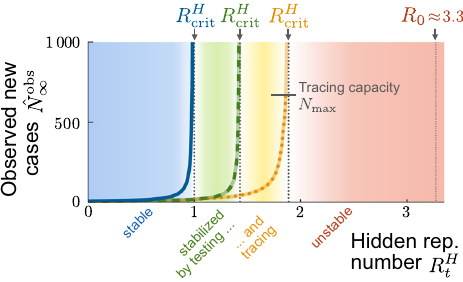
Fig. 5 Testing and tracing give rise to two TTI-stabilized regimes of spreading dynamics. In addition to the intrinsically stable regime of the simple SIR model (blue region), our model exhibits two TTI-stabilized regimes that arise from the isolation of formerly “ hidden ” infected individuals uncovered through symptom-based testing alone (green region) or additional contact tracing (amber region). Due to the external in fl ux, the number of observed new cases reaches a nonzero equilibrium ^ N obs 1 that depends on the hidden reproductive number (colored lines). These equilibrium numbers of new cases diverge when approaching the respective critical hidden reproductive numbers ( R H ) calculated from linear stability crit analysis (dotted horizontal lines). Taking into account a fi nite tracing capacity N shrinks the testing-and-tracing stabilized regime and makes it max metastable (dotted amber line). Note that, for our standard parameter set, the natural base reproduction number R 0 lies in the unstable regime. Please see Supplementary Fig. 5 for a full phase diagram and Supplementary Note 1 for the linear stability analysis.